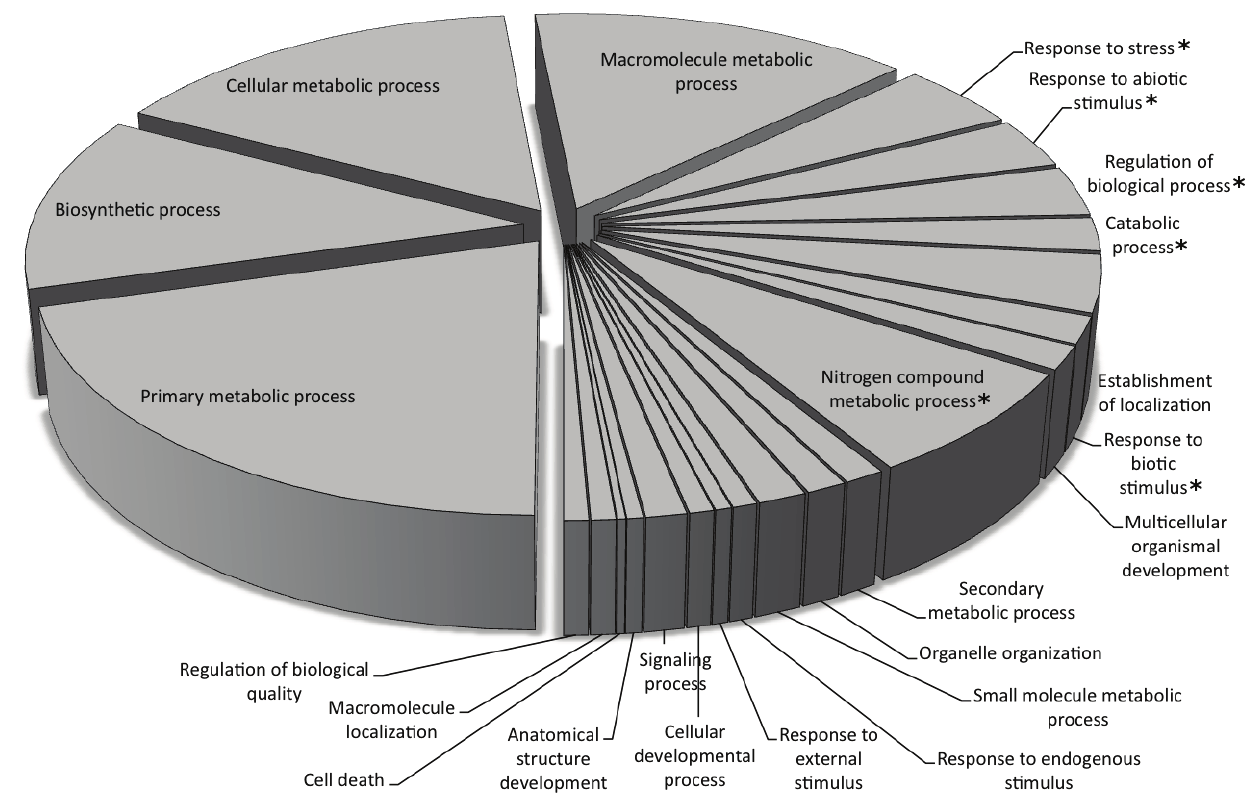
Figure 5. Gene Ontology (GO) annotations of the gene predictions from the repeat-masked dataset in the “ Biological process ” category using BLAST2GO (B2G) [66] using an alpha score of at least 0.6 and an ontology depth level of